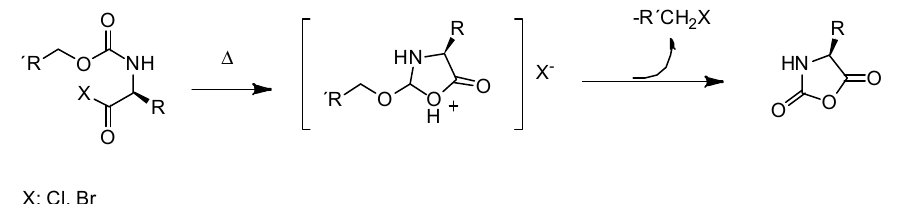
Figure 1. The “Leuchs method” for the preparation of α -amino acid N -carboxyanhydrides involves the cyclization of N -alkoxycarbonyl-amino acids [19].